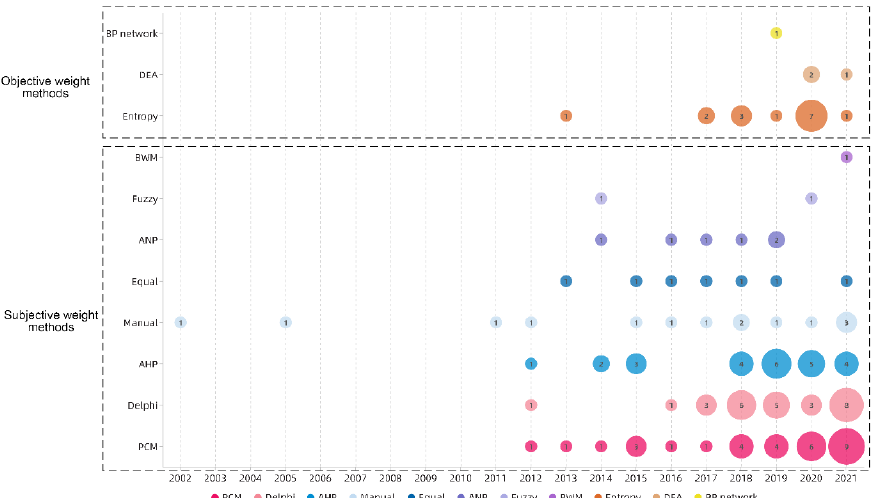
Figure 13. The annual distribution of occurrences of the weighting methods.